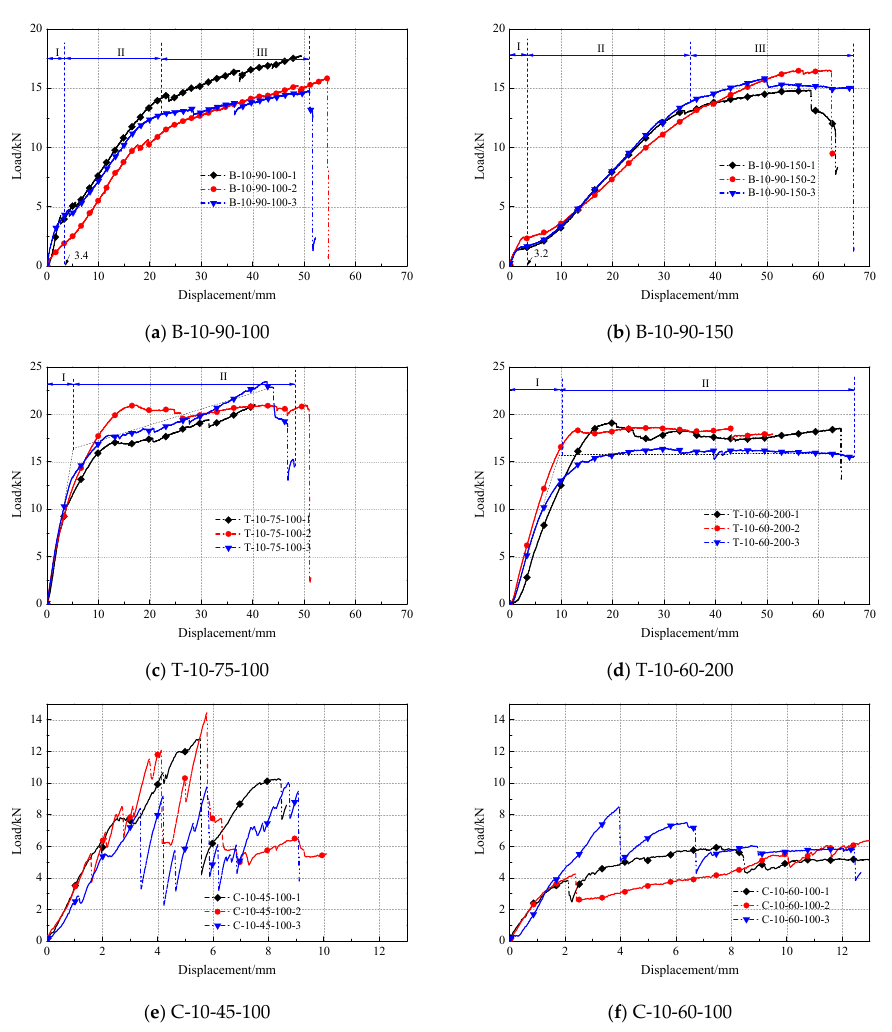
Figure 6. Load-displacement curves.